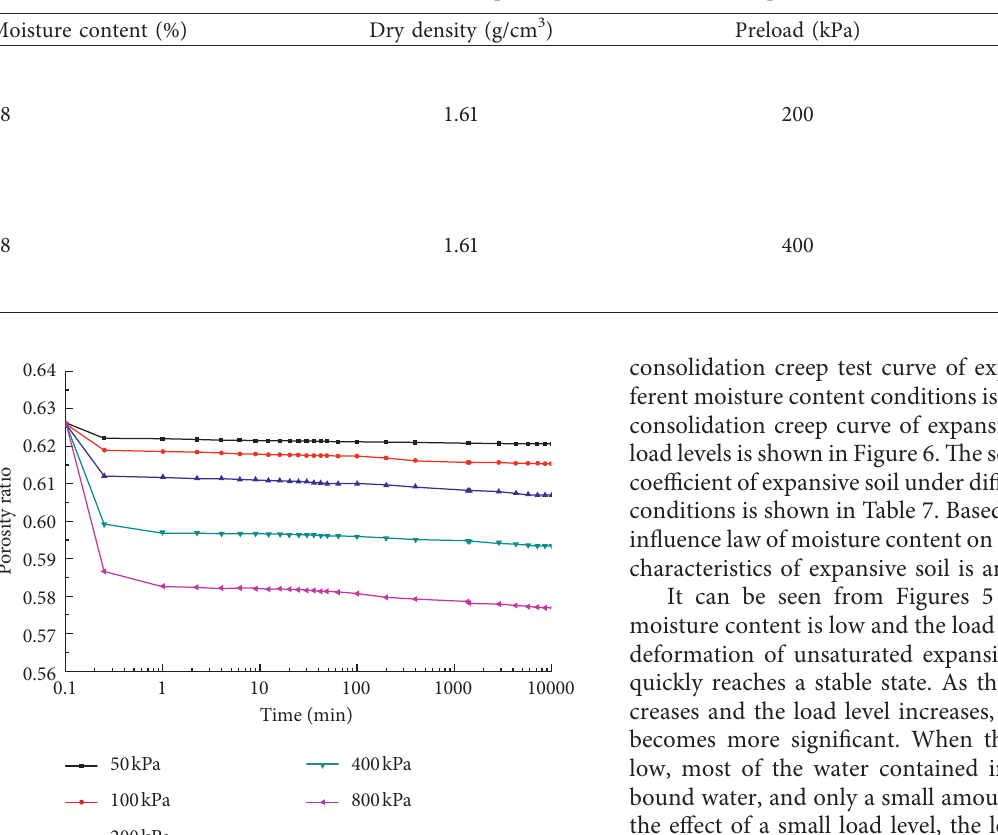
Table 5: Creep test schemes with different preloads.